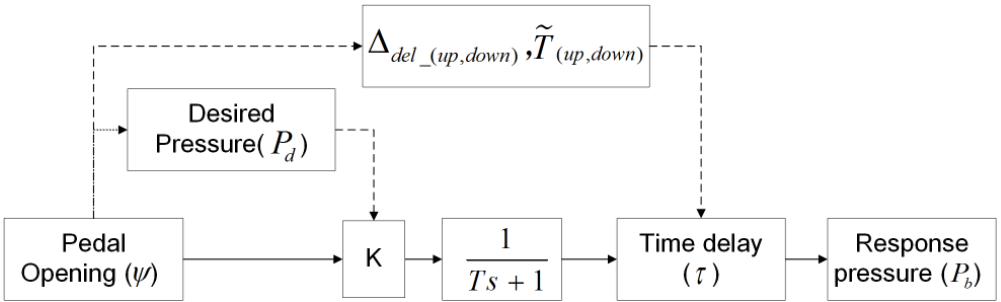
Figure 11. A schematic description of the first-order plus time delay model.